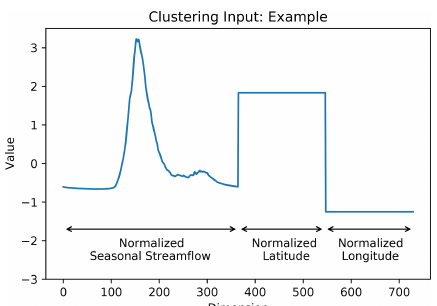
Figure A1. Example of one observation input into the clustering algorithm. The first half of the input vector is the seasonal streamflow (normalized at each station), the third quarter is latitude (normalized across all stations), and the fourth quarter is longitude (normalized across all stations).